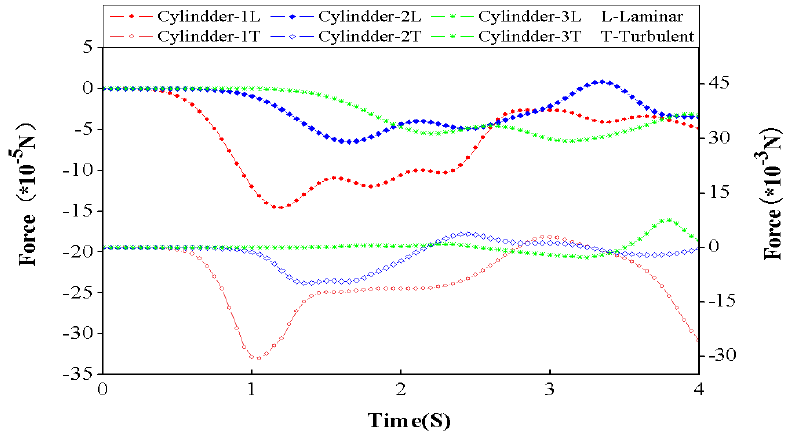
Figure 14. X-direction shear force – time curves for laminar and turbulent flow models.